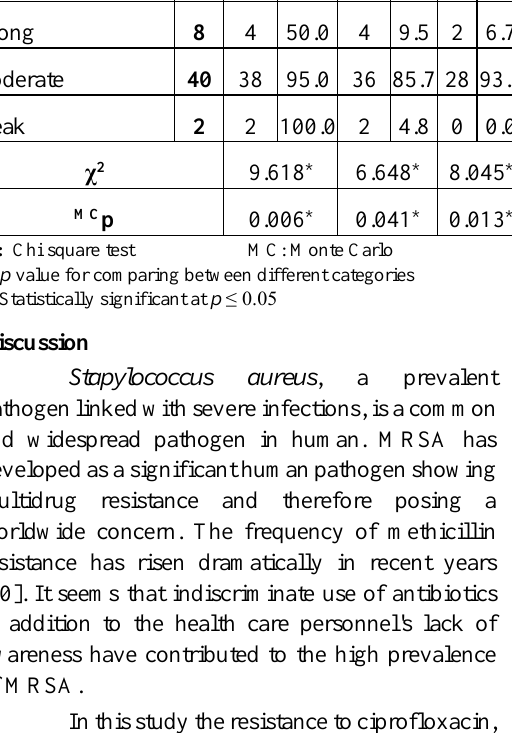
Table 3. Relation between biofilm producer and tested biofilm-related genes . Biofilm